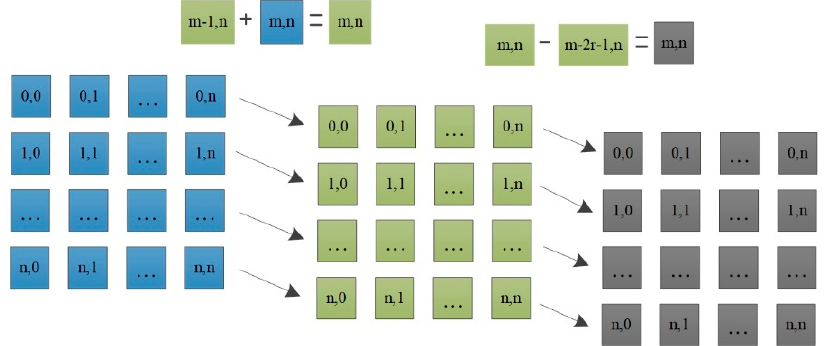
Figure 8. Calculation rule based on the columns of the box filter.